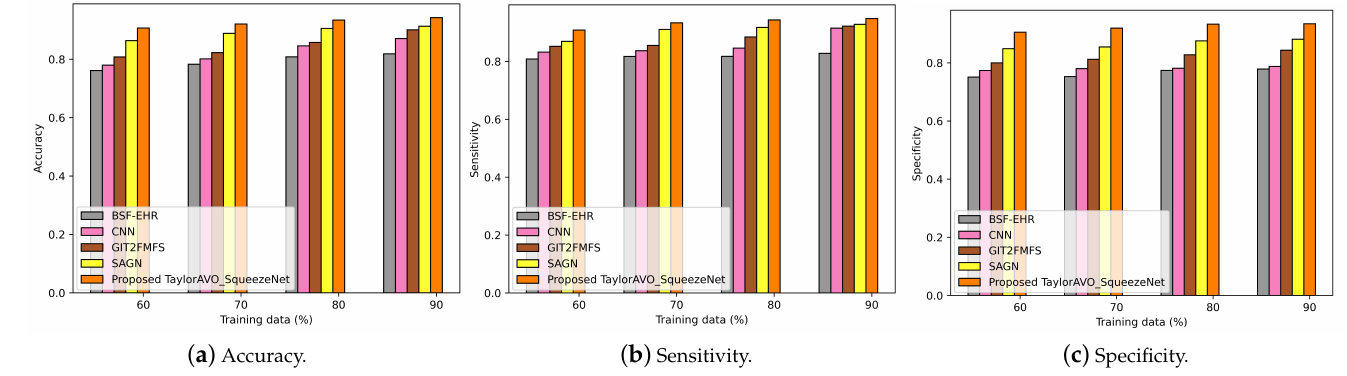
Figure 6. Evaluation of accuracy, sensitivity, and specificity using TaylorAVO-SqueezeNet with other traditional models, varying block size and time.